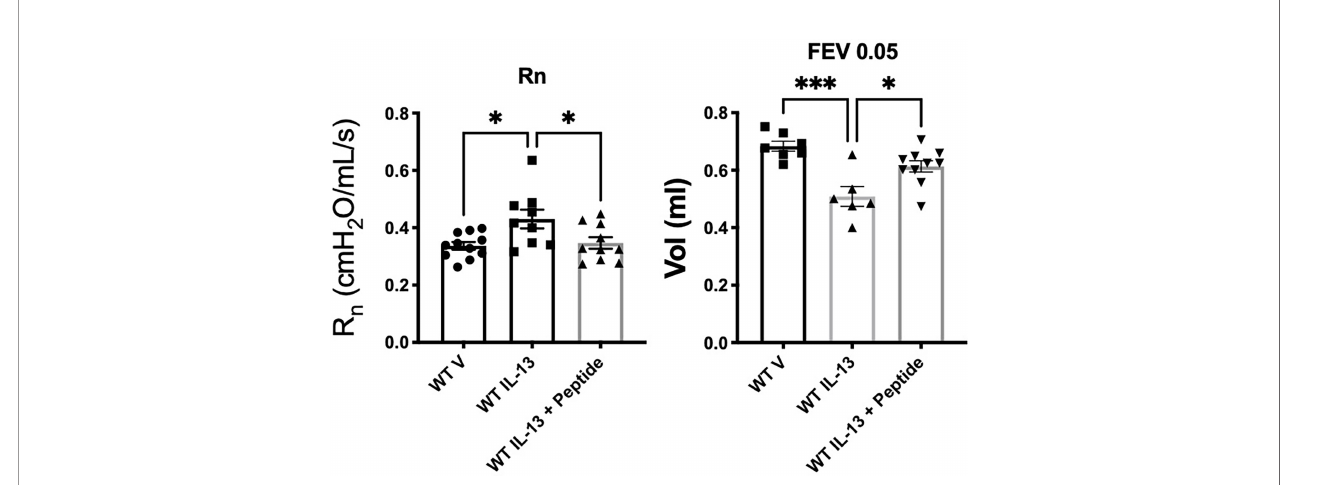
FIGURE 5 | IL-13-challenged mice treated with SP-A 10-mer peptide have improved lung function. WT male mice were challenged with vehicle (saline) or IL-13 (3.9 m g) by oropharyngeal delivery for 3 consecutive days. Two hours after each IL-13 challenge, mice received either vehicle (saline) or SP-A 10-mer peptide (25 m g/ml; ~1mg/kg body weight) via oropharyngeal delivery. Pulmonary function tests were conducted on day 4 on a fl exiVent machine (SCIREQ) with the negative pressure-driven forced expiration (NPFE) extension. IL-13 challenge resulted in signi fi cantly increased Newtonian resistance (Rn) and decreased forced expiratory volumes (FEV) at 0.05 seconds. Treatment with SP-A 10-mer peptide protected against IL-13 induced increase in Rn and decreases in FEV. Average mean +/- SEM is graphed, n= as shown from 2 independent experiments. *p < 0.05, ***p < 0.001 by ANOVA for multiple